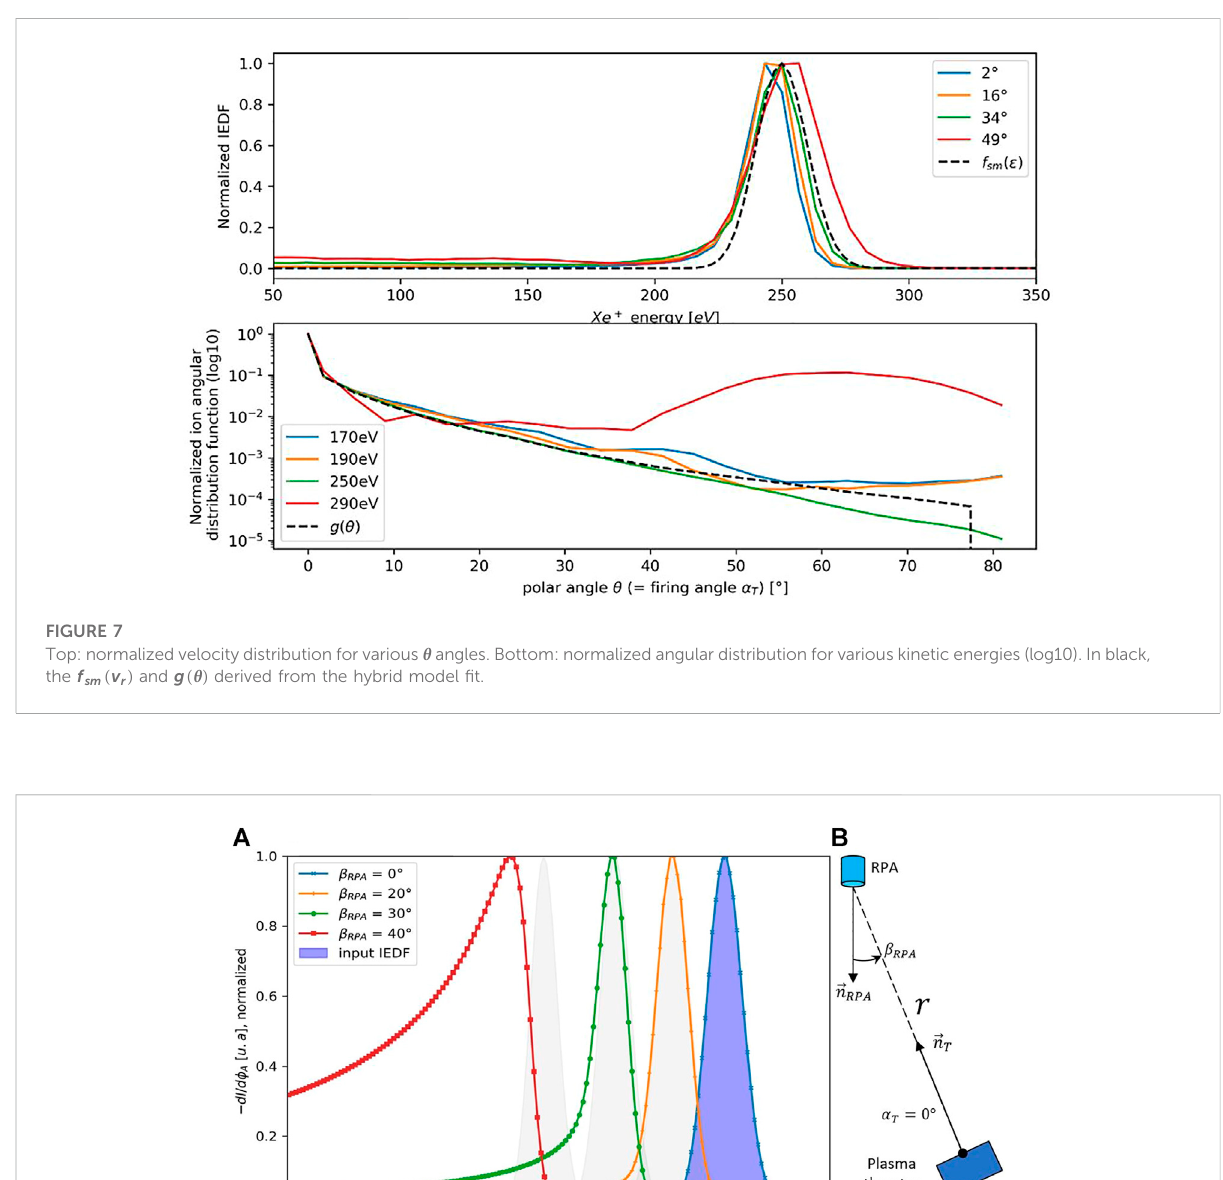
FIGURE 8 (A) − dI / d ϕ A computed at different RPA tilt-angles, (B) Model diagram. The input distribution is a shifted Maxwellian with ε s (cid:2) 250eV and T i (cid:2) 0 . 2eV .